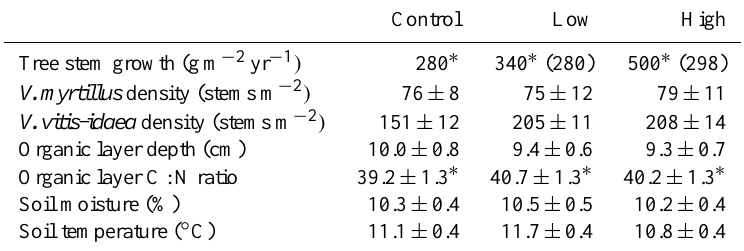
Table 1. Summary of plot characteristics in 2011. Values represent mean ± SE ( n = 17). Soil moisture and temperature values represent means across the growing season (June–August). *From Hasselquist et al. (2012). Tree stem growth values in brackets represent means for the three years prior to